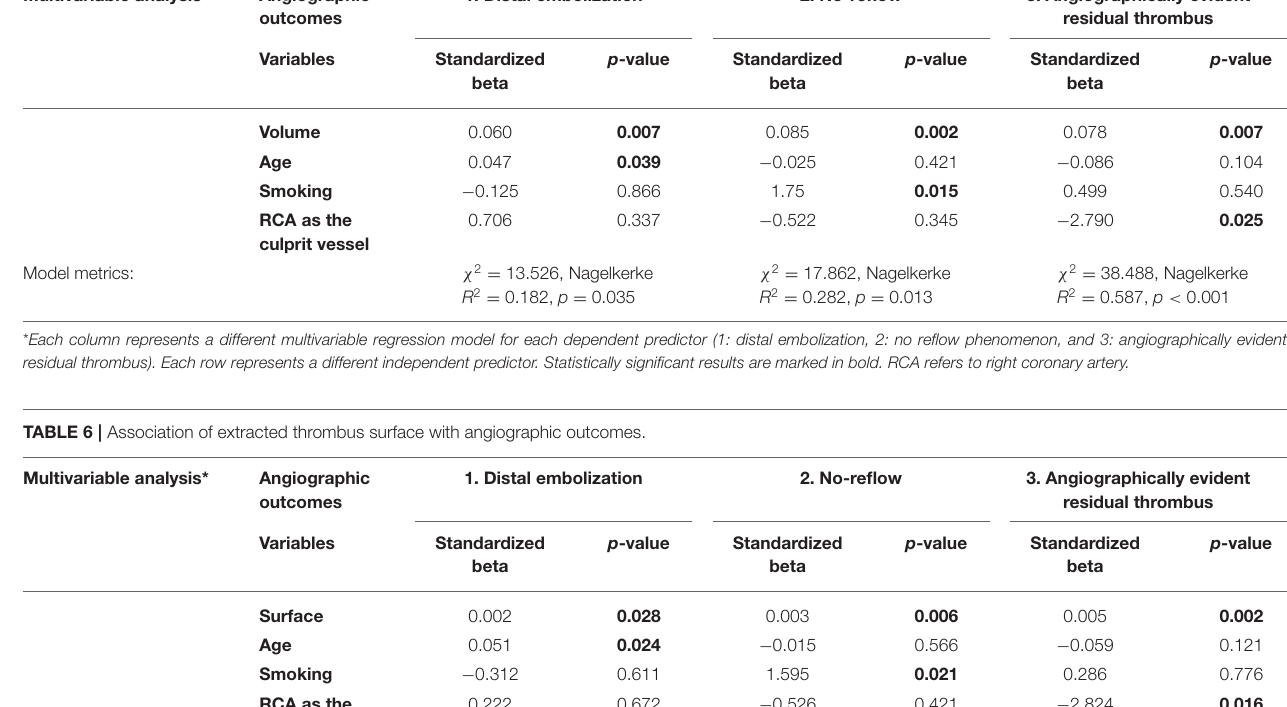
TABLE 5 | Association of extracted thrombus volume with angiographic outcomes. Multivariable analysis*